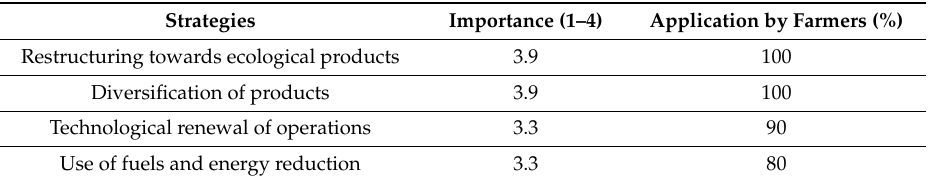
Table 3. Technical-entrepreneurial dimension strategies